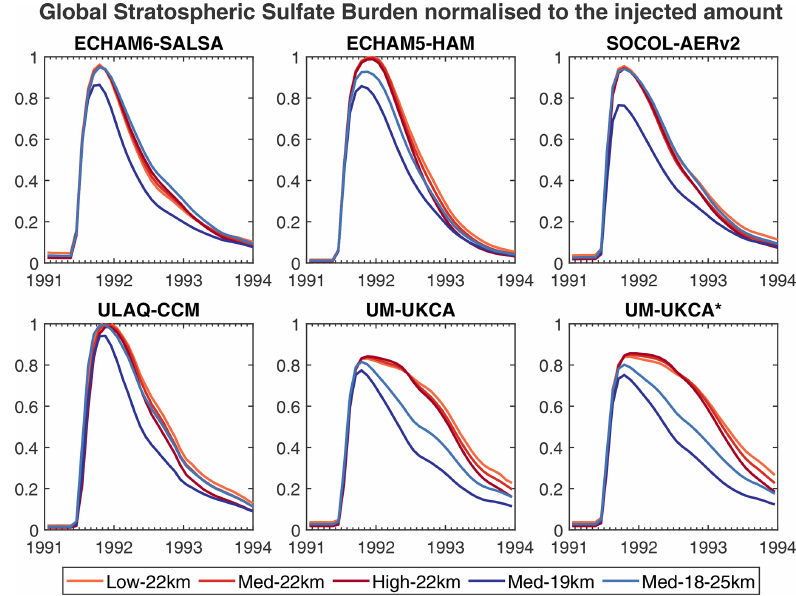
Figure 6. Time evolution of global stratospheric sulfate burden normalized to the amount of injected SO 2 . Each panel refers to the respective model in which the different experiments are